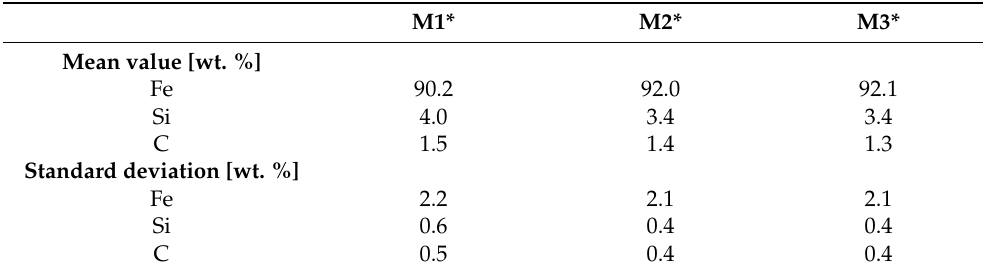
Table 5. Mean values and standard deviations [in wt. %] of the microprobe analysis. M1* M2* M3* Mean value [wt.